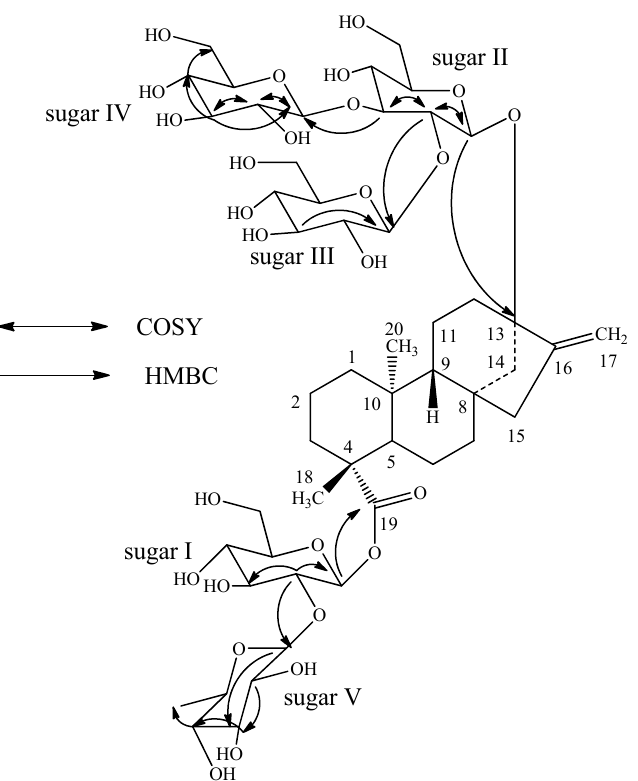
Figure 2. Key COSY and HMBC correlations of 1